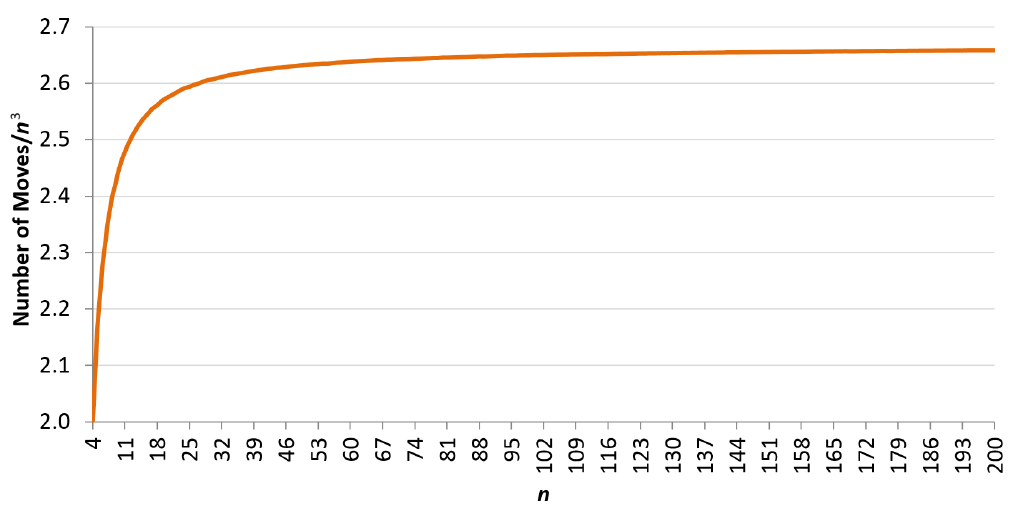
Figure 6. The average number of moves required to solve 10,000 random instances of the ( n 2 − 1) -puzzle divided by n 3 for 4 ≤ n ≤ 200